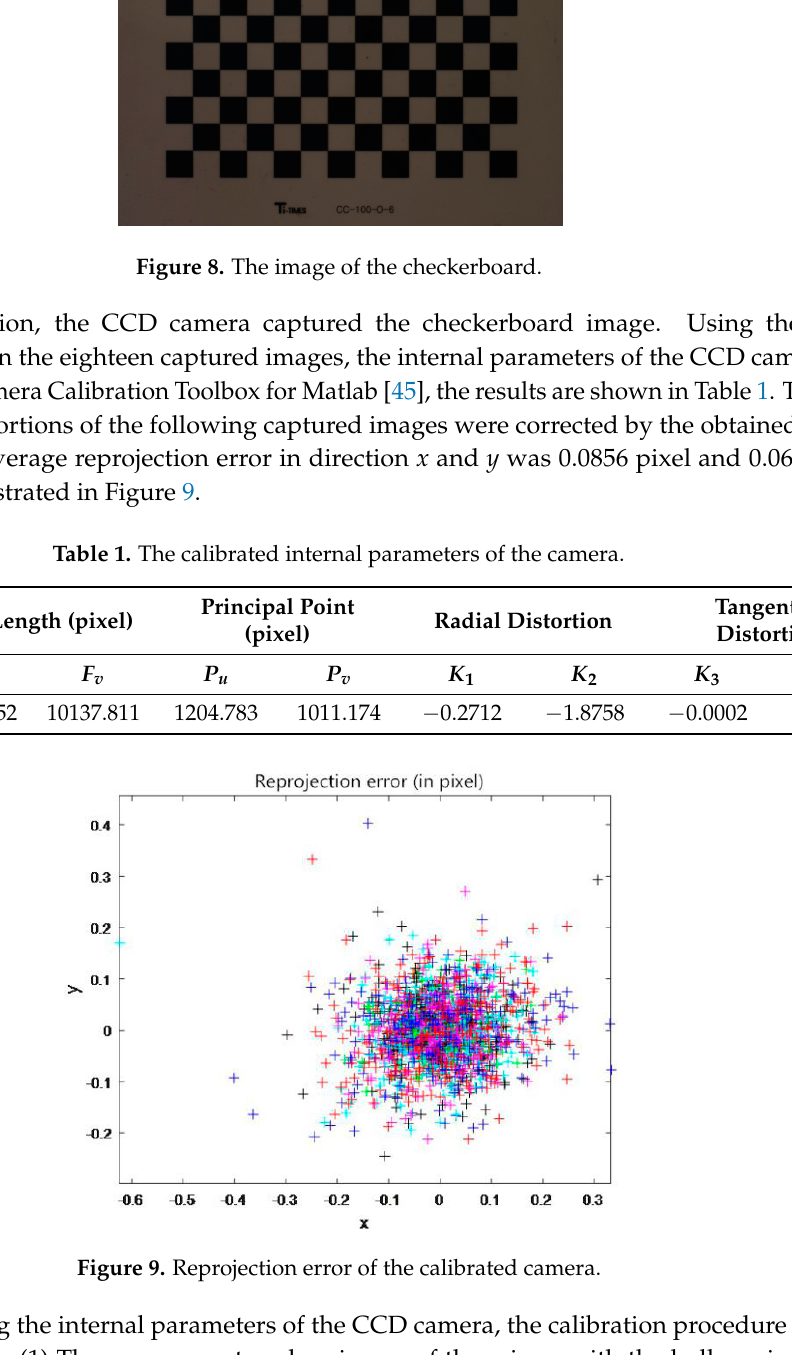
Figure 7. Setup for the experiments using the DPMD technique. 4.2. Calibration experiments Table 1. The calibrated internal parameters of the camera.